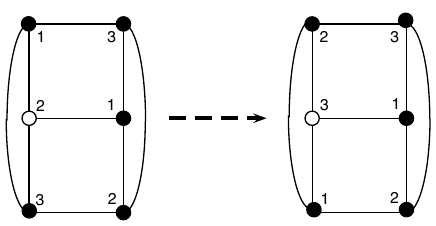
Figure 1: Every proper 3-coloring of K 2 × K 3 is robust.